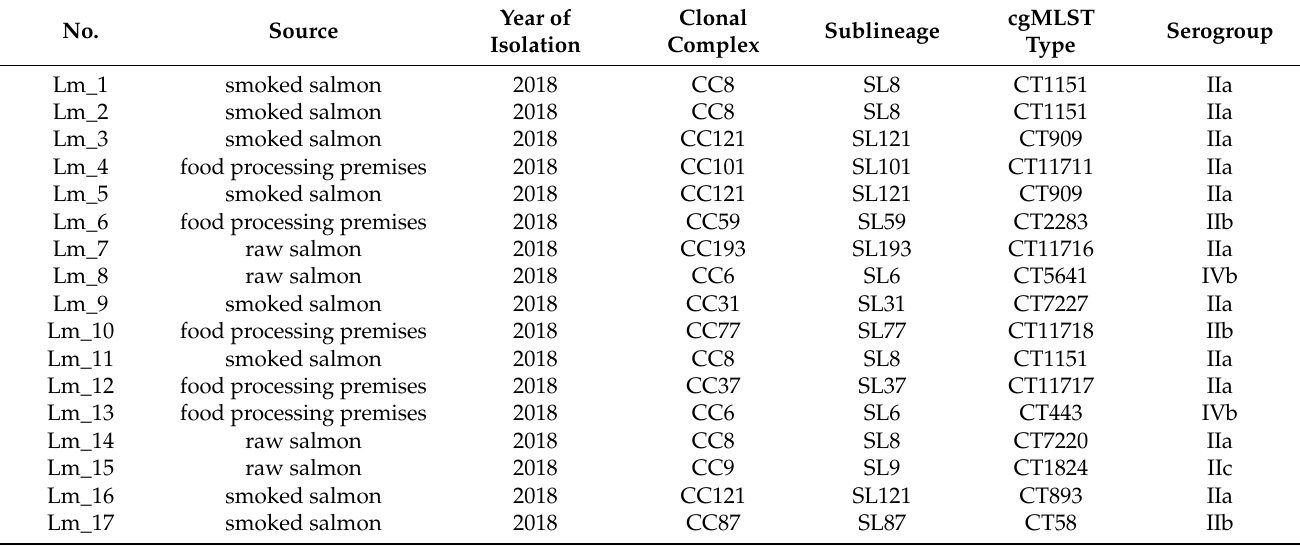
Table 1. List of Listeria monocytogenes strains used in